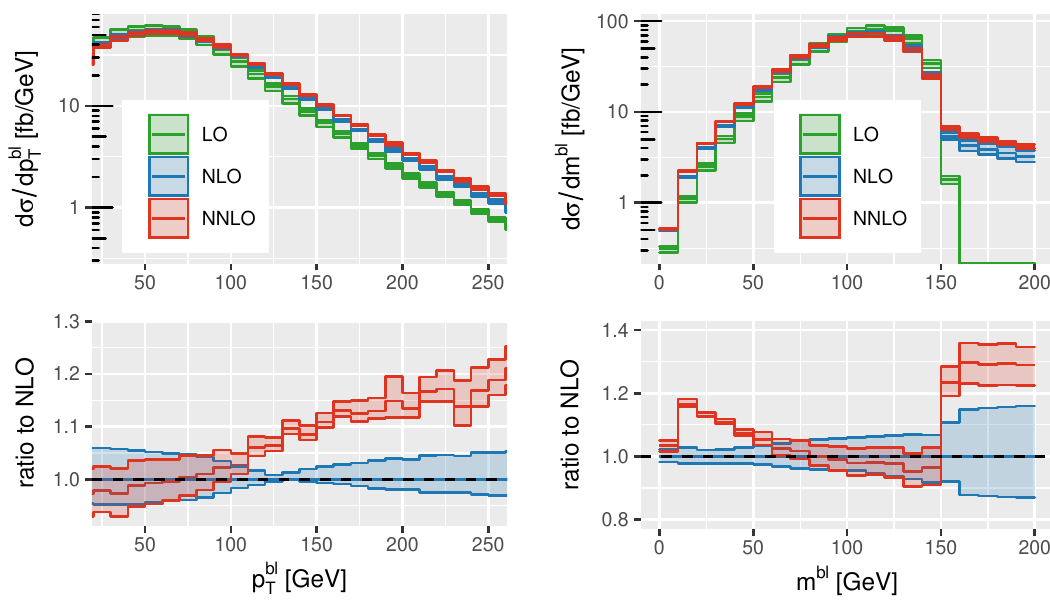
Figure 18 . Leading b -tagged jet plus lepton transverse momentum distribution (left) and invariant mass distribution